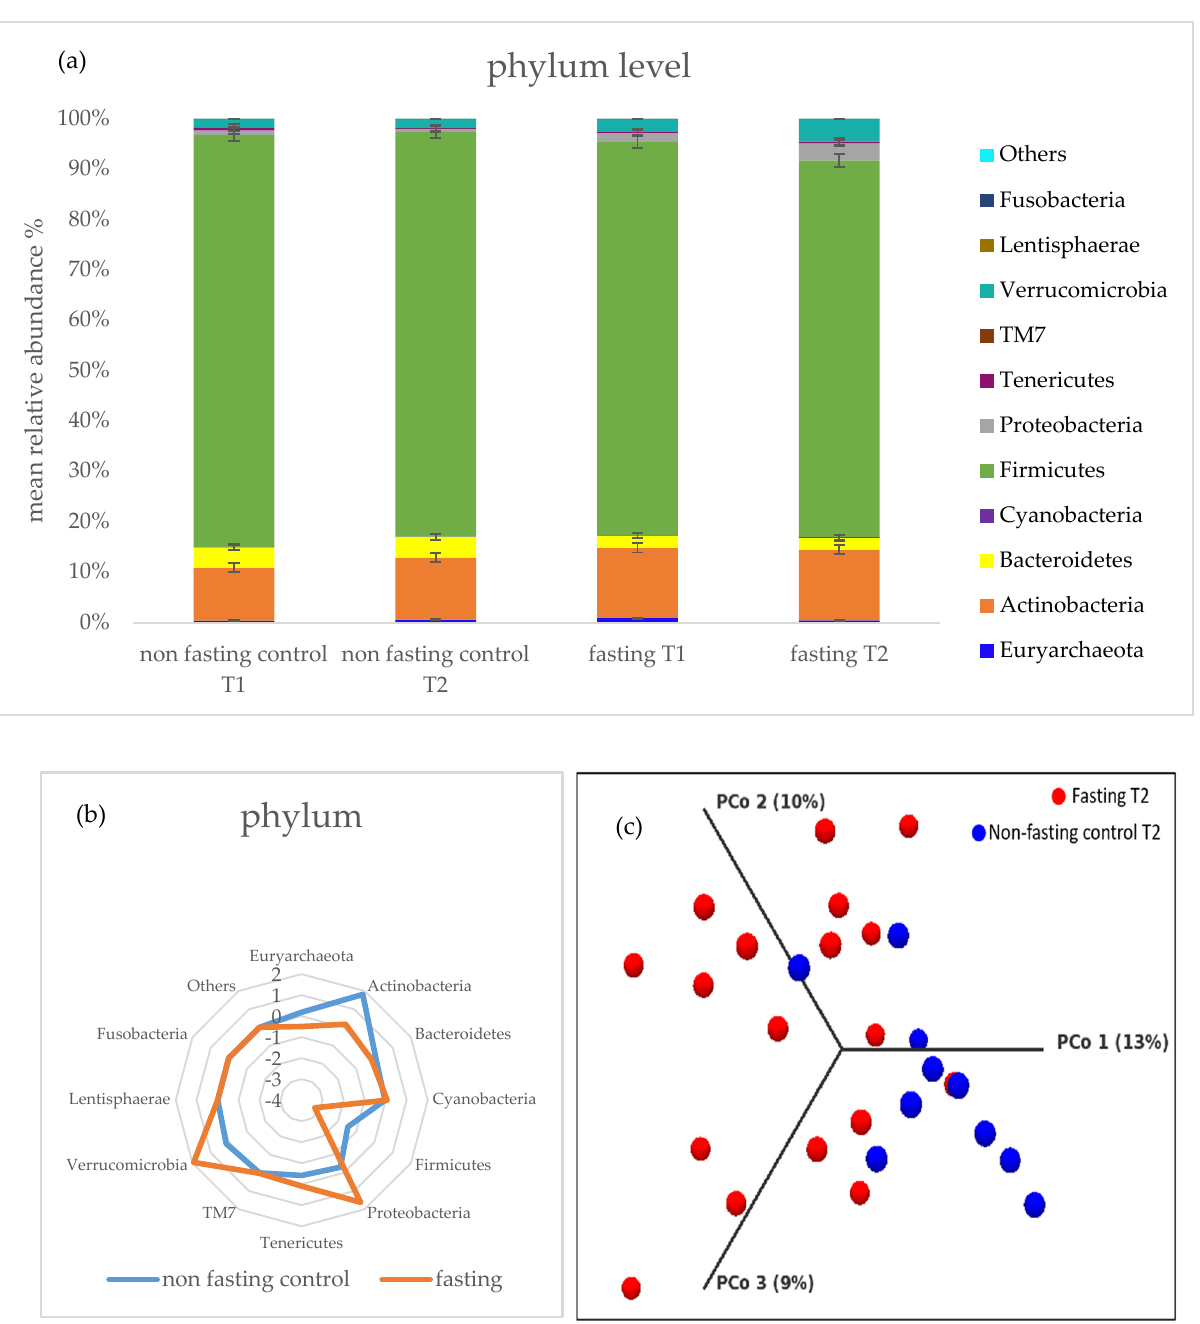
Figure 4. The dissimilarity of the microbiota composition of the non-fasting control and fasting group. ( a ) Bar charts of sequencing data given in mean +/ − SD relative bacteria abundance in % at phylum level for non-fasting and fasting group. ( b ) Major differences between non-fasting and fasting groups at the phylum level. Values are given as the mean abundance of T2–T1. ( c ) PCoA based on Bray–Curtis dissimilarity index showing cluster for fasting and non-fasting group at T2. Permutational multivariate analysis of variance (PERMANOVA; p = 0.00004) was applied for the analysis.